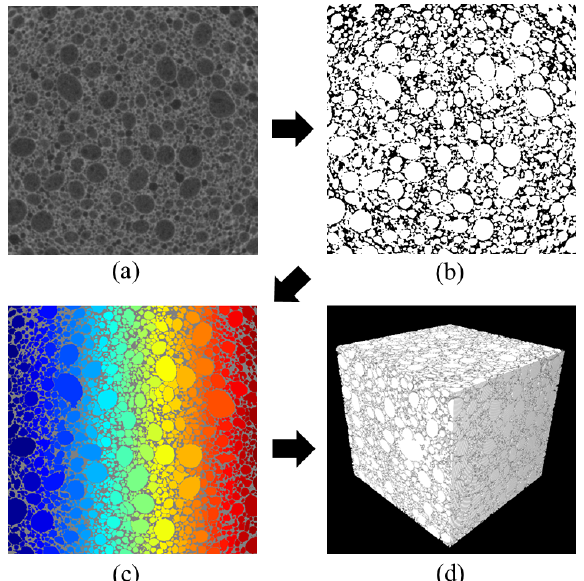
Figure 4. CT imaging of LWC specimen (LW 23): ( a ) region of interest (ROI) of the original 8-bit CT image; ( b ) binarized image; ( c ) classification of lightweight aggregates; ( d ) 3D image of lightweight aggregate part (note: in the binary image ( b ), the white represents aggregate parts, and the black represents mortar parts of the specimen. In the Figure ( c ), each color denotes a distinct